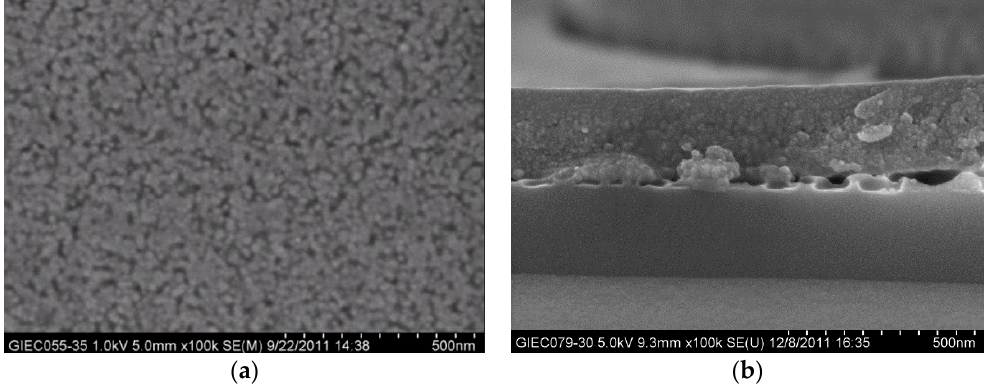
Figure 2. The SEM images of surface ( a ) and cross-section ( b ) of the BST/BNF/BST films on Pt(111)/Ti/SiO 2 /Si(100) substrates annealed 650 ° C for 30 min in an oxygen atmosphere. Pt(111) / Ti / SiO 2 / Si(100) substrates annealed 650 ◦ C for 30 min in an oxygen